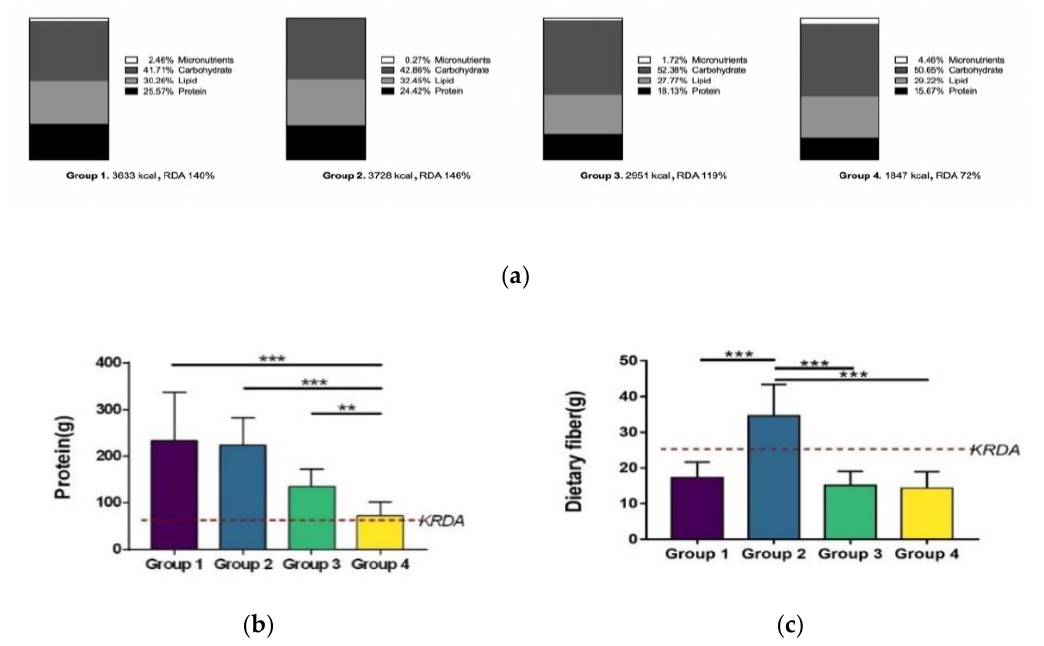
Figure 4. Nutritional intake analysis. ( a ) the proportion of carbohydrate, protein, fat, and dietary fiber in the total energy intake (TE) of each group is plotted. Protein intake decreased from group 1, which